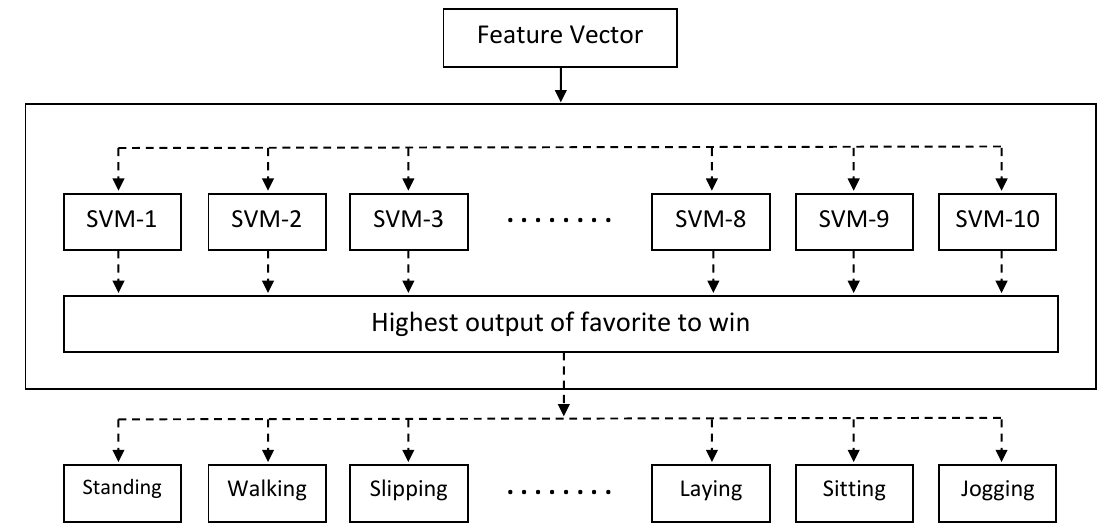
Figure 4. Architecture of OAA SVM classifier for activity